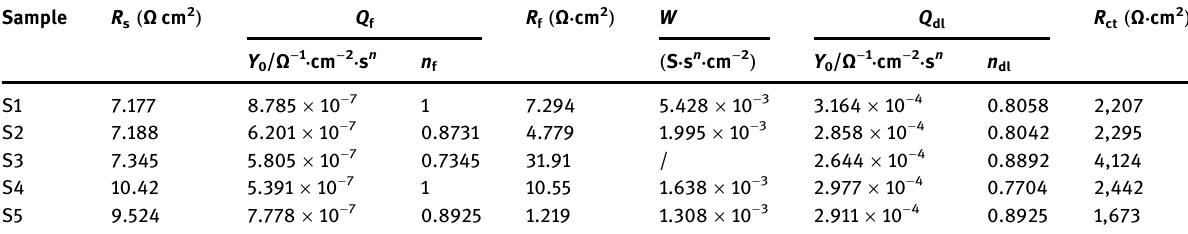
Table 4: Fitting parameters for S1 – S5 samples in 3.5 wt% NaCl solution obtained by ZSimpWin from the EIS data Sample